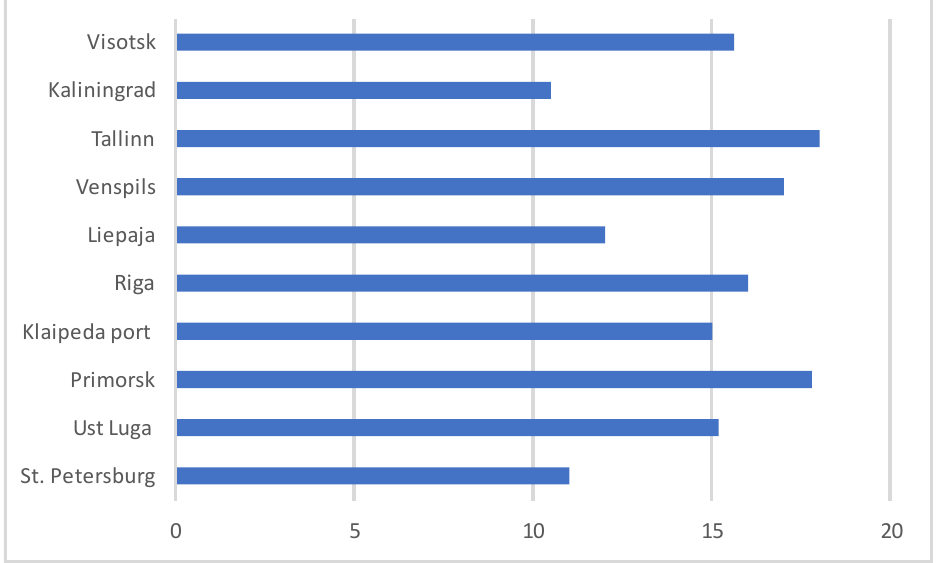
Figure 15. Length of quays (kilometers).